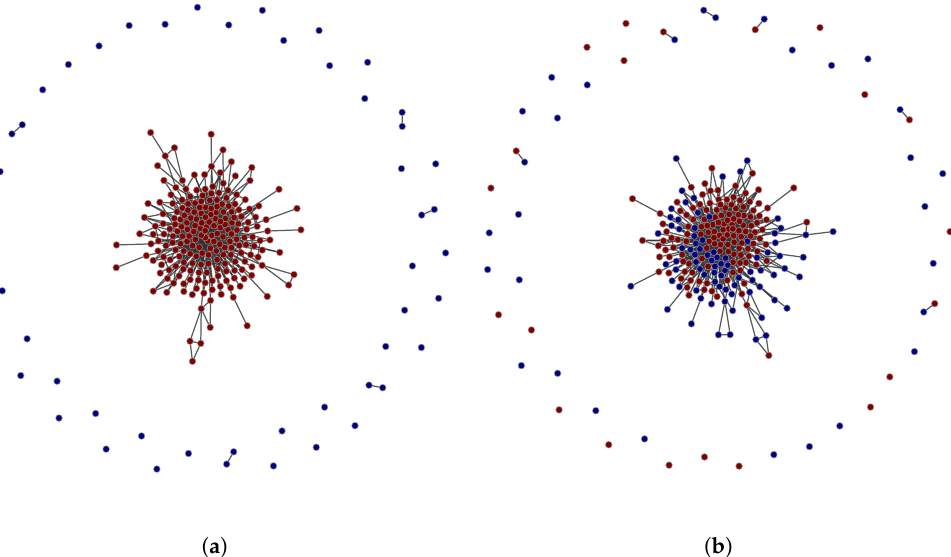
Figure 6. The crowd as a network. ( a ) the detected crowd shown as linked red points; ( b ) Topic #176 related individuals shown as red